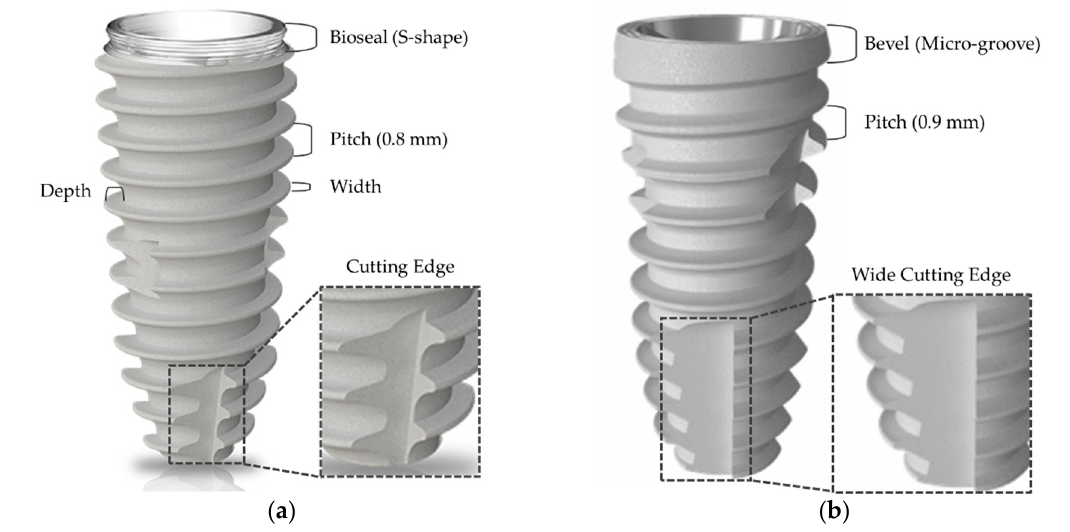
Figure 1. Implant macro design parameters in dental fixtures. ( a ) CMI IS-II active; ( b ) CMI IS-III active.